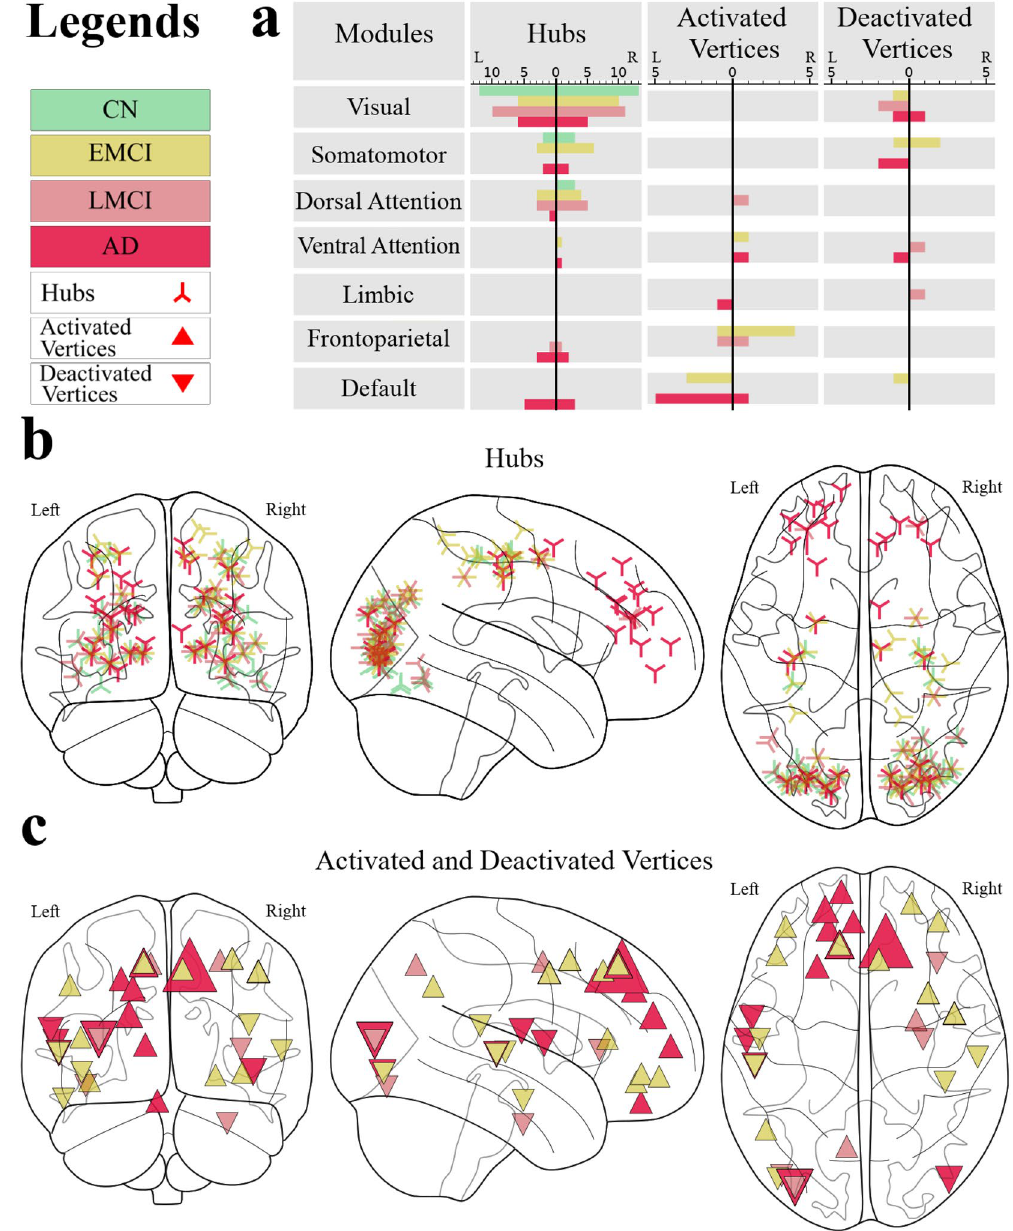
Figure 4. The distribution of hubs, activated areas, and deactivated areas shows that anterior regions are more engaged in the diseased groups. ( a ) The frequency distribution across the 7-module parcellation. The left and right sides of each sub-plot denoted by a vertical black line represent the distribution across modules limited to the left and right hemispheres, respectively ( b ) The spatial distribution of the hub regions. The vertex size is proportional to the vertex strength. ( c ) The spatial distribution of vertices that are activated (denoted by (cid:31) ) and deactivated (denoted by (cid:31) ) in the diseases. A vertex was called activated (deactivated) with respect to disease if the subtraction of its strength in the disease network from the CN network was significantly larger (smaller) than the similar value for other vertices. The vertex size is proportional to the value of this subtraction. Visualizations in ( b ) and ( c ) were created using Nilearn